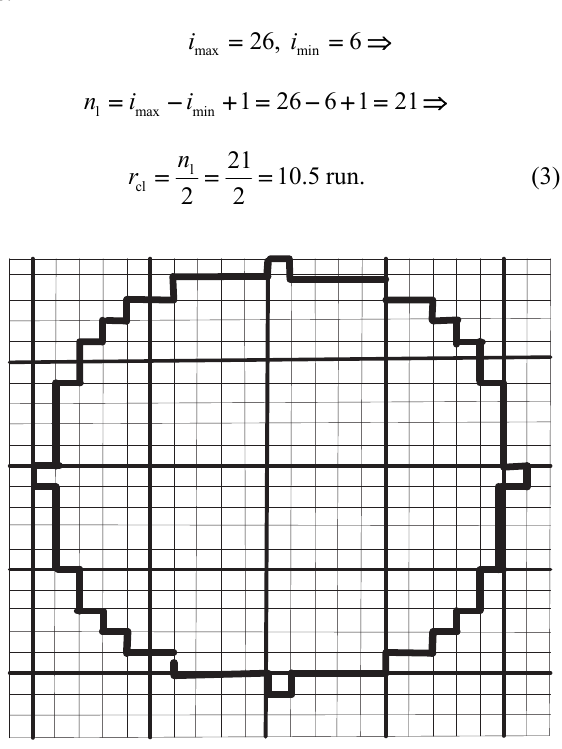
Fig. 1. Raster graphics for the round mark